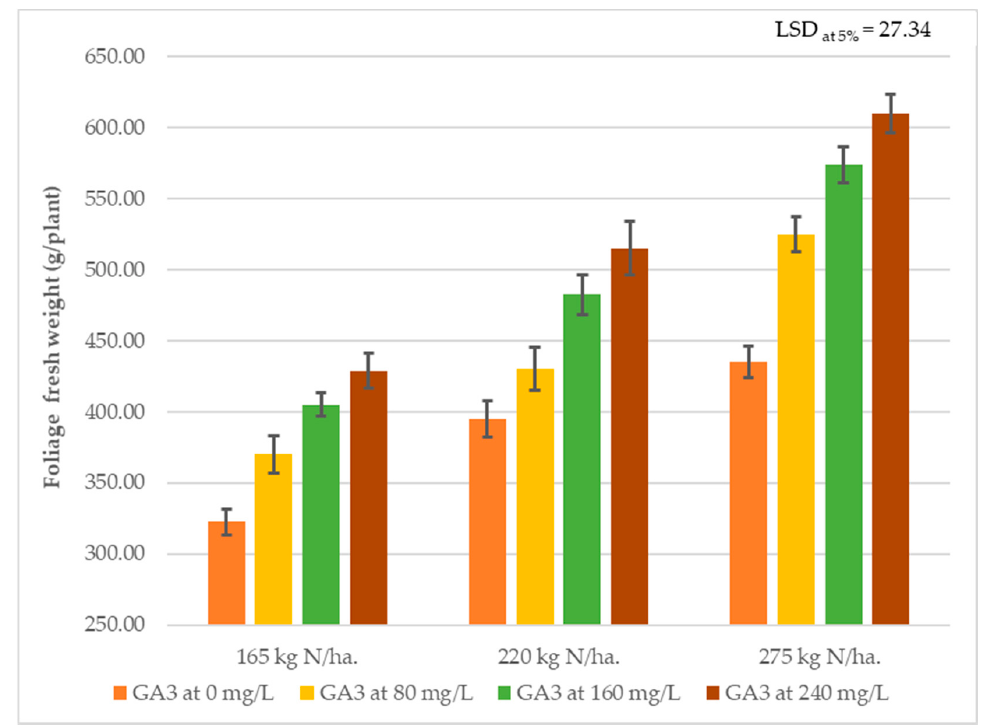
Figure 5. Foliage fresh weight (g/plant) as affected by the interaction between nitrogen fertilizer levels and GA 3 spraying concentrations in the first season (2014/2015).